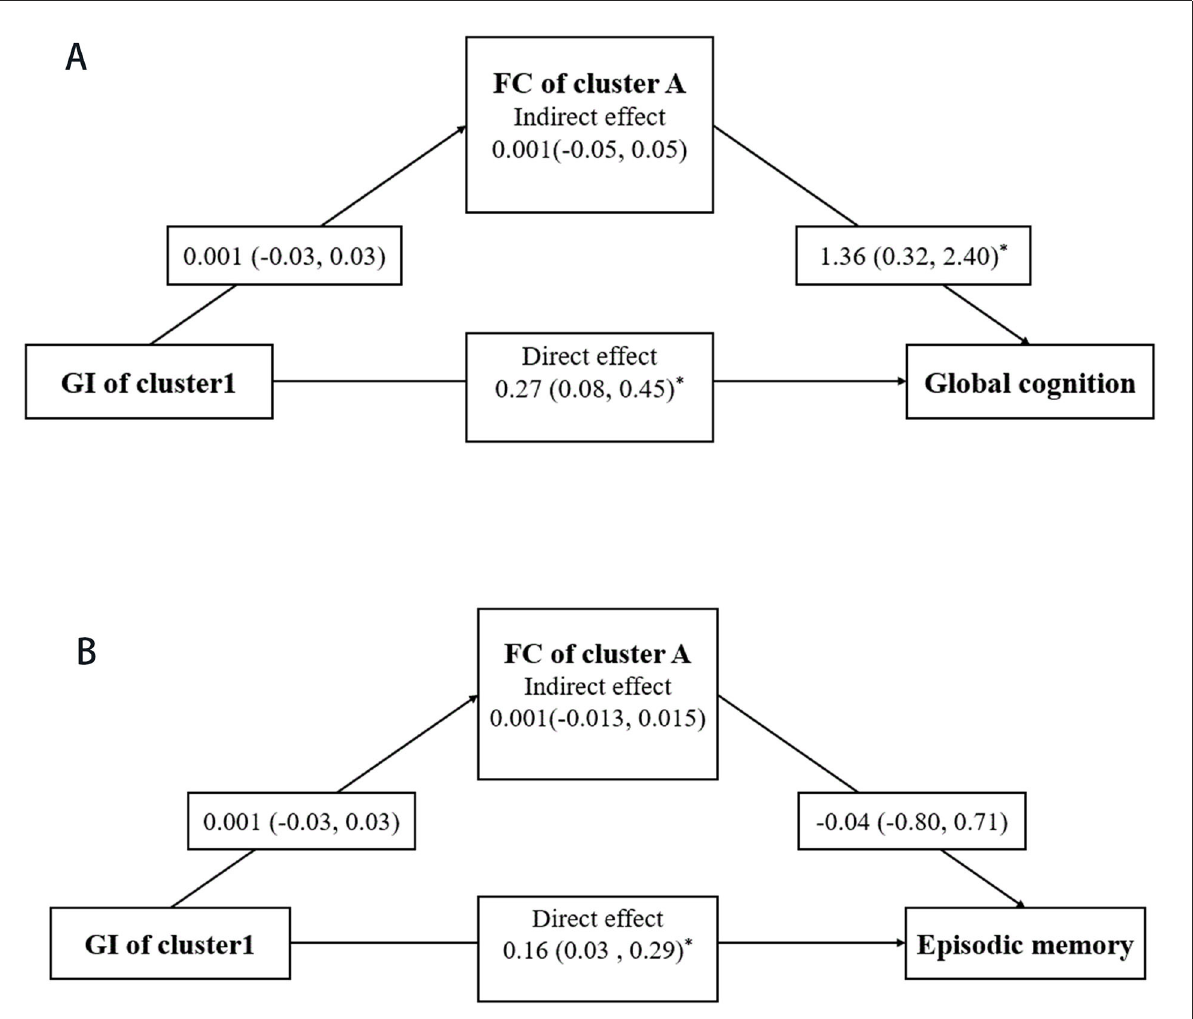
FIGURE5 Mediation analysis. Mediating effects of RSFC in the associations of GI with global cognition (A) and episodic memory (B) . Mediation models were adjusted for age, gender, education, FPG, and PWMH. For each connection, the β coefficient and corresponding 95% confidence interval (CI) are shown. * represents the significant pathway ( p <